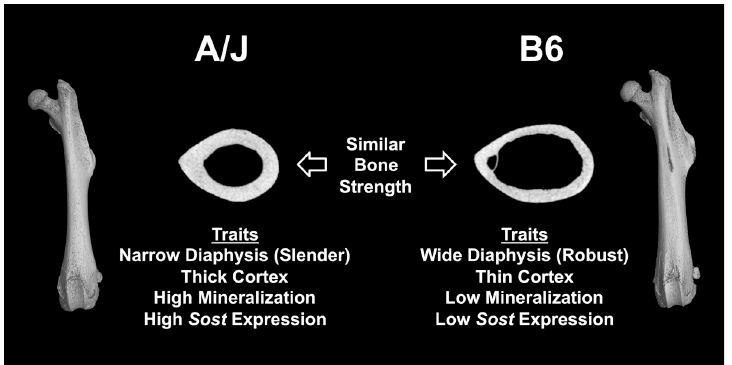
Fig 1. Schematic of key morphological, compositional, and molecular differences between A/J and B6 femurs. Despite variation in traits, both bones establish similar organ level mechanical function at musculoskeletal maturity. Adapted from Schlecht et al